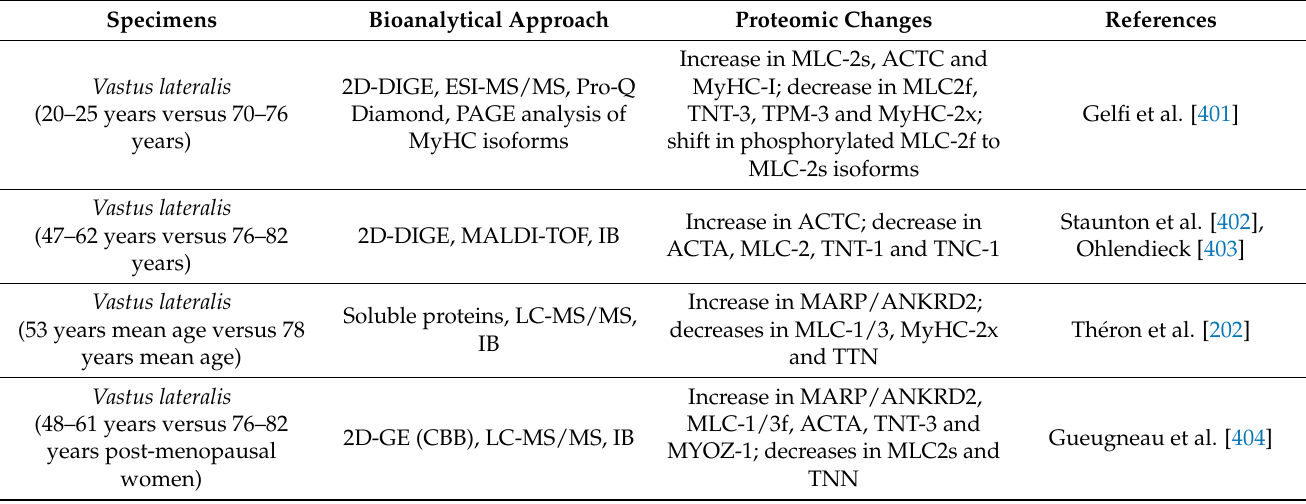
Table 2. List of major mass-spectrometry-based proteomic profiling studies focusing on contractile proteins in aged human skeletal muscle